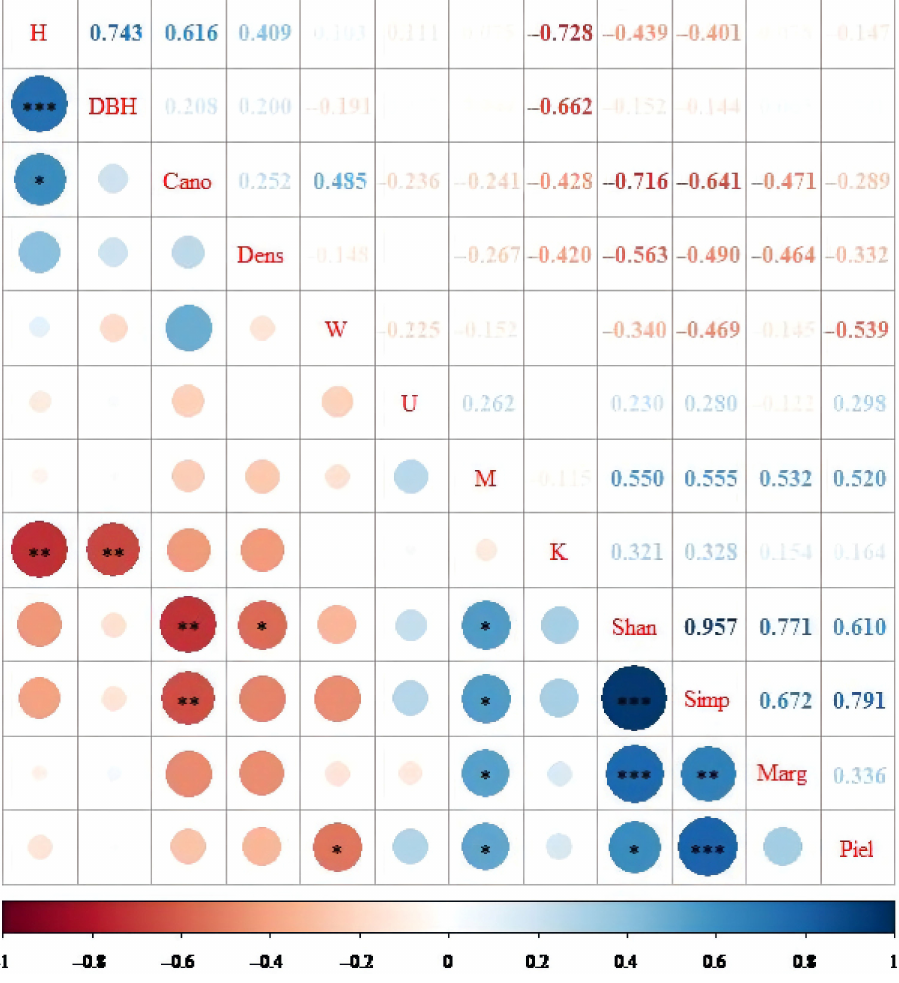
Figure 3. Correlation coefficients between stand structure and understory herbaceous plants species diversity. Note: ***: p < 0.001; **: p < 0.01; *: p < 0.05. H—Tree Height; Cano—Canopy density; Dens—Tree density; W—Uniform angle; U—Neighborhood comparison; M—Mingling degree; K—Opening degree; Shan—Shannon–Wiener index; Simp—Simpson index; Marg—Margalef richness index; Piel—Pielou evenness